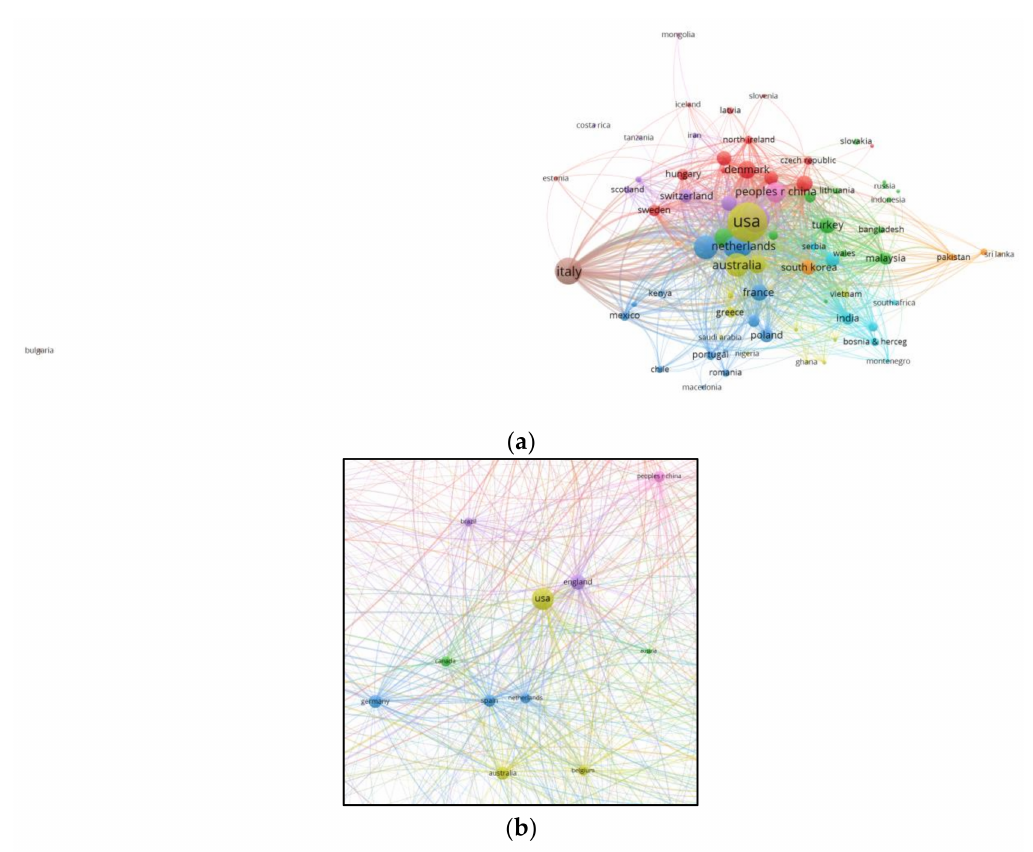
Figure 2. Network visualization map for the item countries (1 as the minimum number of documents of a country). ( a ) Original figure. ( b ) Enlargement of figure around the